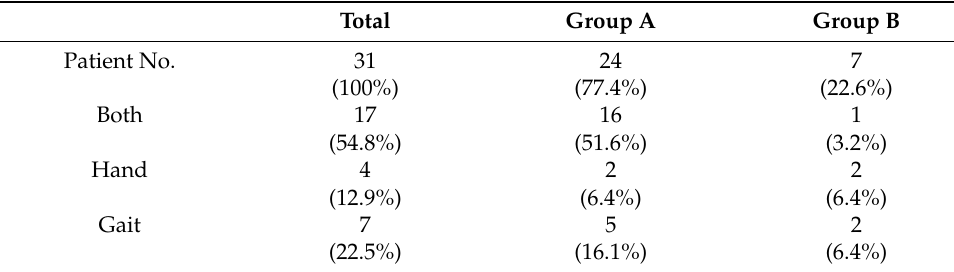
Table 3. Distribution of good outcomes at the second clinical